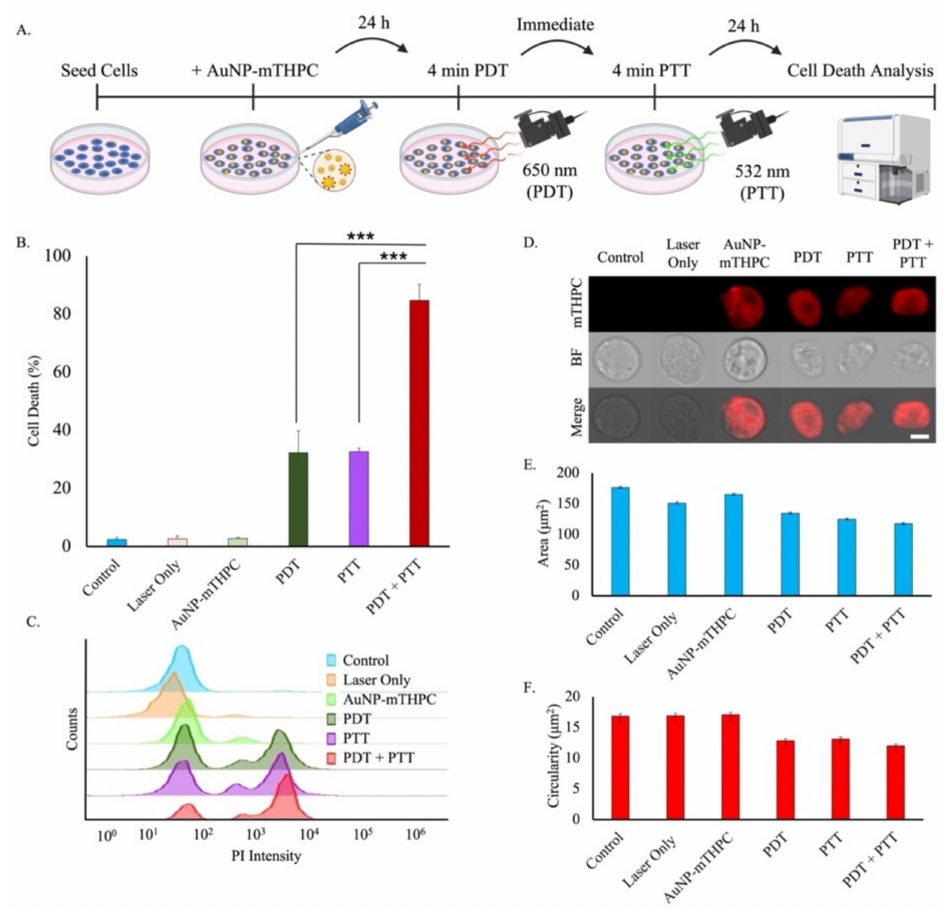
Figure 5. Cell death and cellular morphology changes induced by laser irradiation after 24-h incuba- tion with AuNP–mTHPC complex. ( A ) Schematic representation of PDT/PTT procedure. ( B ) Cell via- bility of SH-SY5Y cells with AuNP–mTHPC and illuminated under 650-nm laser (PDT) at 6 mW/cm 2 for 4 min or/and illuminated under 532-nm laser (PTT) at 15 mW/cm 2 for 4 min. The average quantification of three experiments is presented in the plots (mean ± STDEV). There were significant differences in some of the experiments. *** p < 0.001. ( C ) Flow cytometry PI representative results. ( D ) Instances of images from different conditions captured by ImageStreamX on the Bright Field (DIC) channel and mTHPC (red) fluorescence channels. Scale bar = 7 µ m. ( E ) Averaged area of cells for each type of irradiation (mean ± SE). ( F ) Averaged circularity of cells for each type of irradiation (mean ±